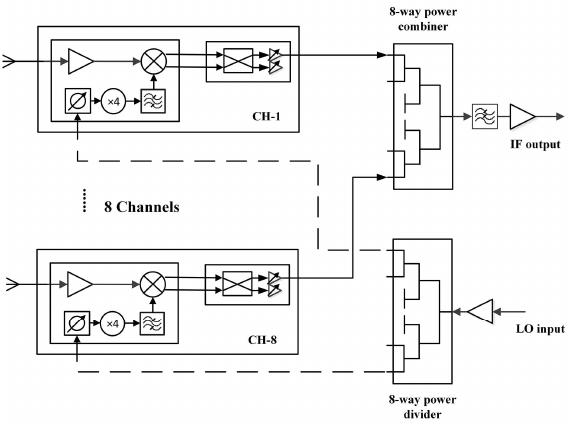
Figure 10. Schematic of the proposed phased array receiver front end.